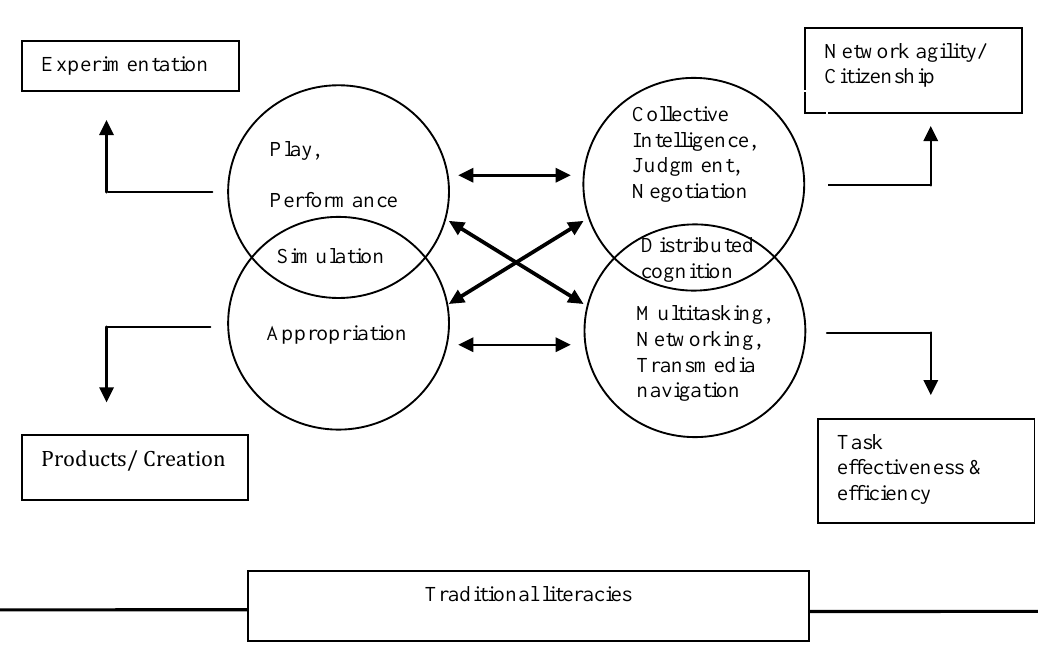
Figure 1 . Clustering of media literacies. Adapted from Jenkins et al.